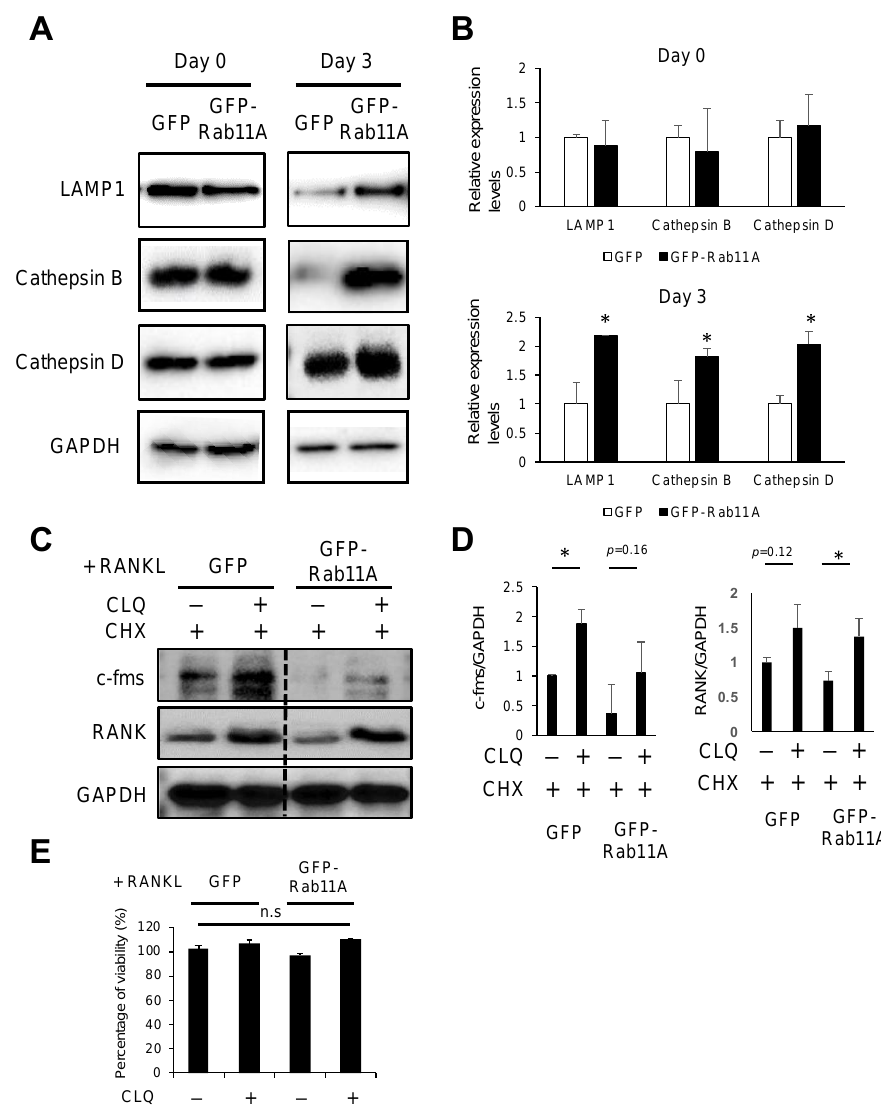
Figure 8. The lysosomal function on c-fms and RANK protein degradation ameliorated by Rab11A overexpression in RAW-D cell-derived osteoclasts. ( A ) The endogenous levels of LAMP1 (a specific lysosomal receptor), and Cathepsins B and D (two major lysosomal enzymes) in GFP or GFP-Rab11A-expressing RAW-D cells following RANKL stimulation for 0 (left panel) or 3 days (right panel) were analyzed by WB with anti-rat LAMP1, anti-rabbit Cathepsins B and D, and GAPDH-HRP (loading control). ( B ) Quantitative analyses of Western blot for LAMP1, Cathepsin B, Cathepsin D. GAPDH was used as an internal control. * p < 0.05. ( C ) After 3 days of RANKL (300 ng / mL) stimulation, RAW-D cell-derived osteoclasts were treated simultaneously with 20 µ g / mL CHX and with or without 10 µ M CLQ for 3 h. c-fms and RANK protein levels were assessed by WB with anti-mouse c-fms, anti-mouse RANK, and GAPDH-HRP (loading control) antibodies. ( D ) Quantitative analyses of Western blot for c-fms and RANK. GAPDH was used as an internal control. * p < 0.05. ( E ) Cell viability was assessed by the cellular ATP content measurement using the CTG Assay system. After stimulated with RANKL (300 ng / mL) for 3 days, RAW-D cells were subsequently added with 20 µ g / mL CHX and with or without 10 µ M CLQ for 3 h. The values were the average of triplicate determinations with the S.D indicated by error bars. n.s; no significant.